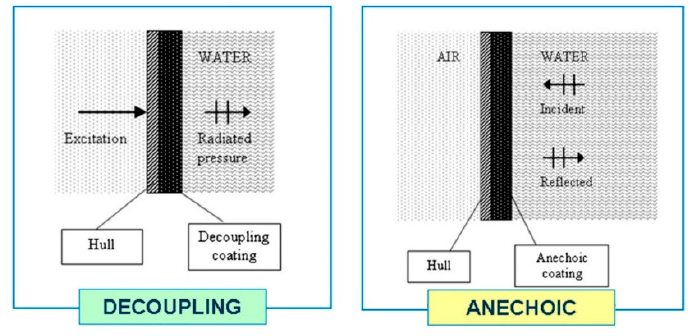
Figure 1. Two main types of acoustic coating [9].